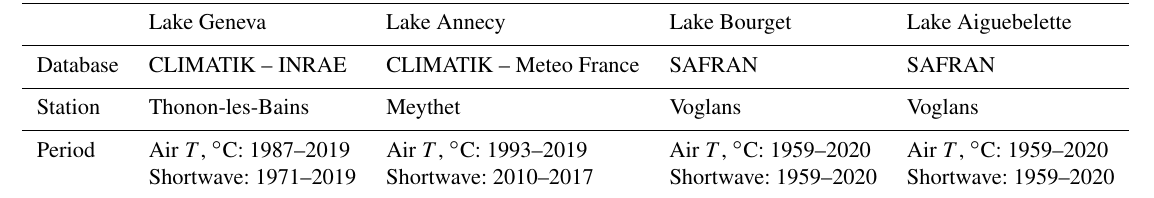
Table 5. Meteorological data sources used to calculate the correction factors applied to air temperature ( T , ◦ C) and shortwave radiations, for the four study